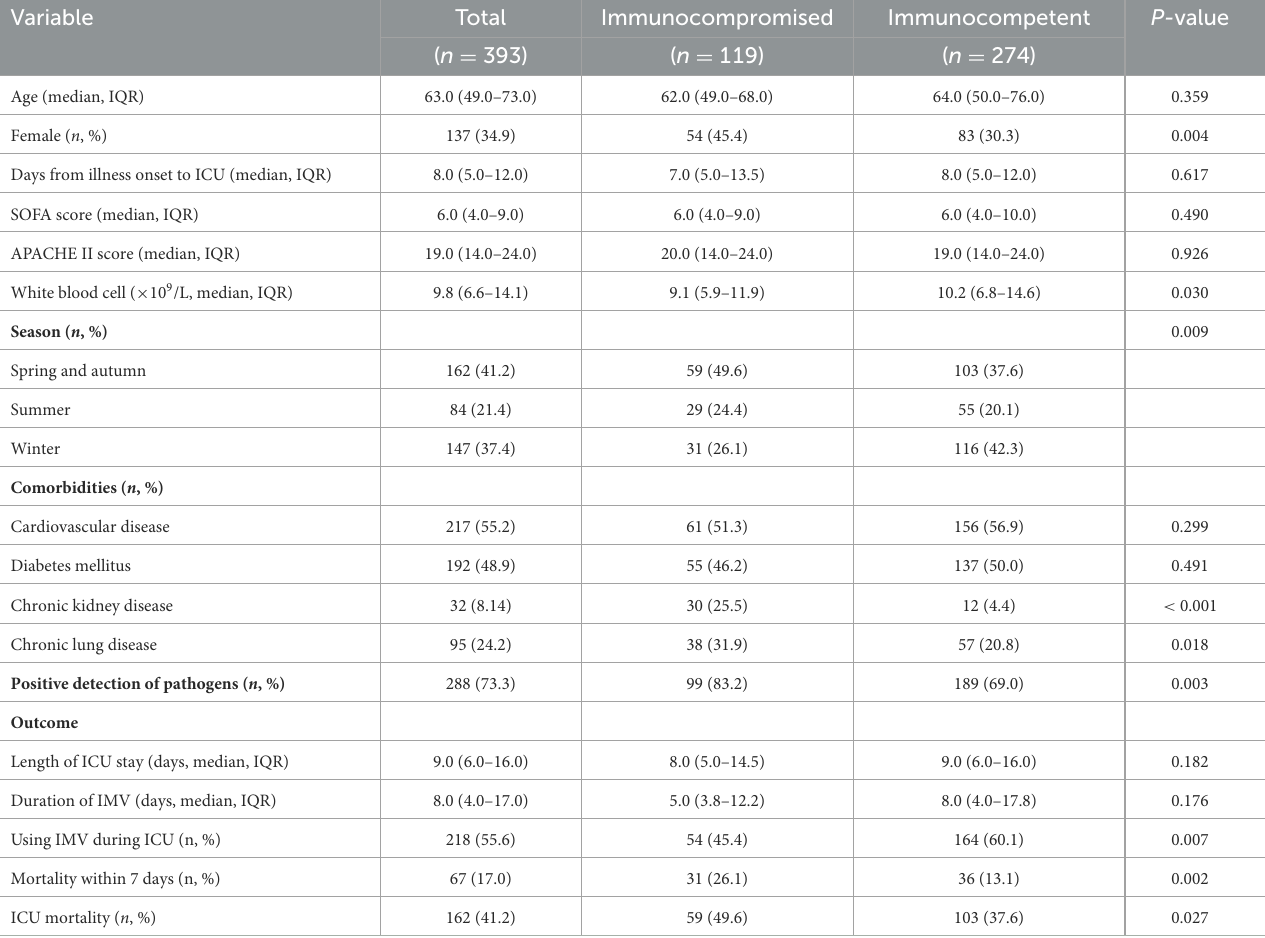
TABLE 1 The clinical characteristics and outcomes of patients with severe community-acquired pneumonia. Variable